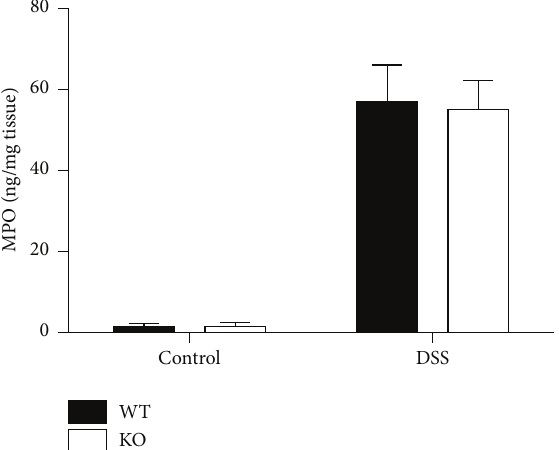
Figure 5: Myeloperoxidase (MPO) levels in colonic tissue in DSS colitis. MPO was measured by ELISA in colonic tissue homogenates from wild-type (WT) and Cyp4f18 knockout (KO) mice treated for 9 days with 4% DSS in drinking water (error bars represent SEM, 𝑛 = 5 ). Control mice received drinking water without DSS.